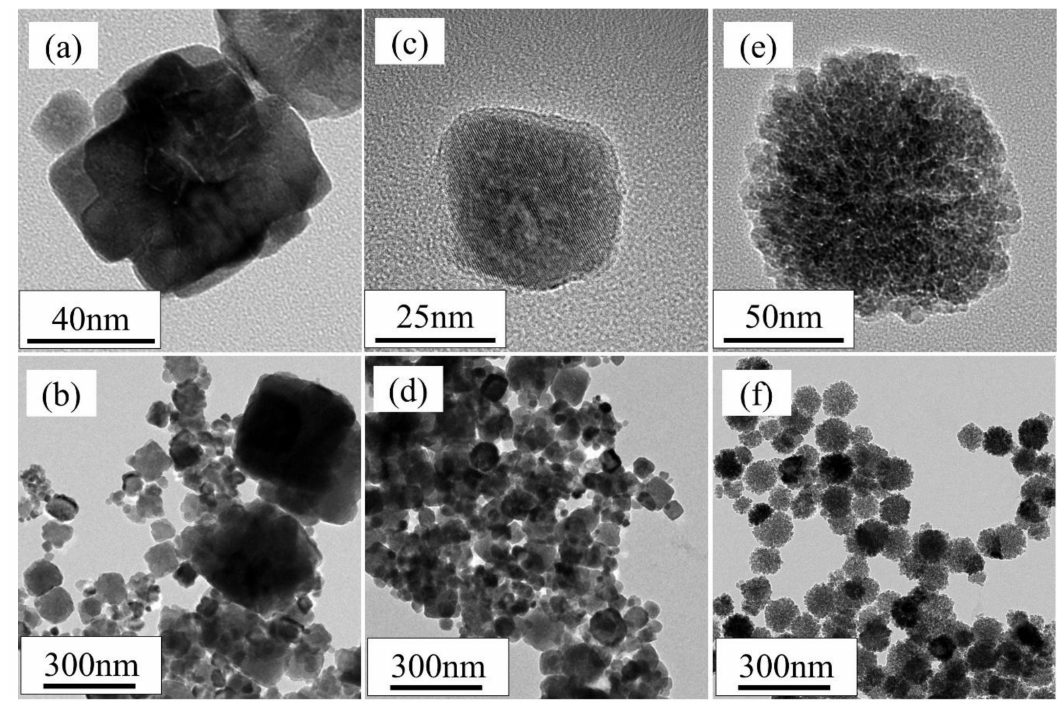
Figure 2. Transmission electron microscopy (TEM) images of Co oxide nanoparticles synthesized ( a , b ) without added ligands; ( c , d ) with sodium acetate; and ( e , f ) with sodium